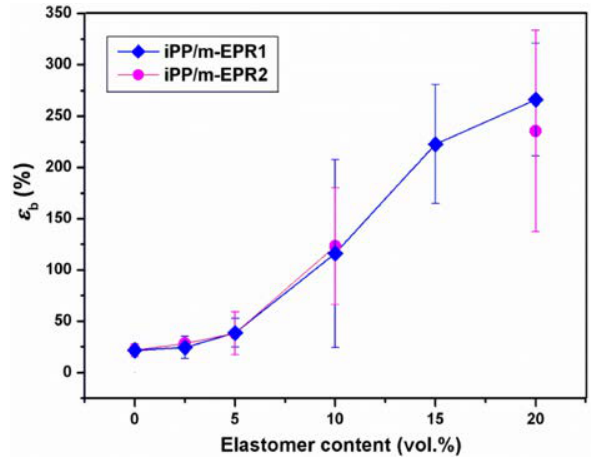
Figure 6. Elongation at break of the iPP/m-EPR blends in depend- ence on volume content of added